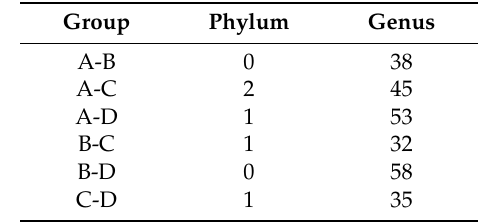
Table 4. Statistical results for Metastats for pairwise comparison test among the different samples (groups).